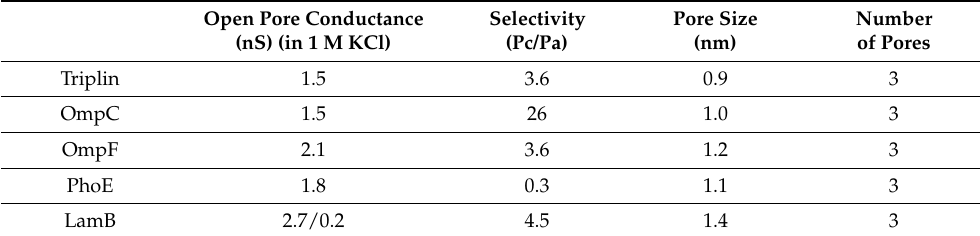
Table 1. Properties of Triplin and those of some porins. Open Pore Conductance (nS) (in 1 M KCl)